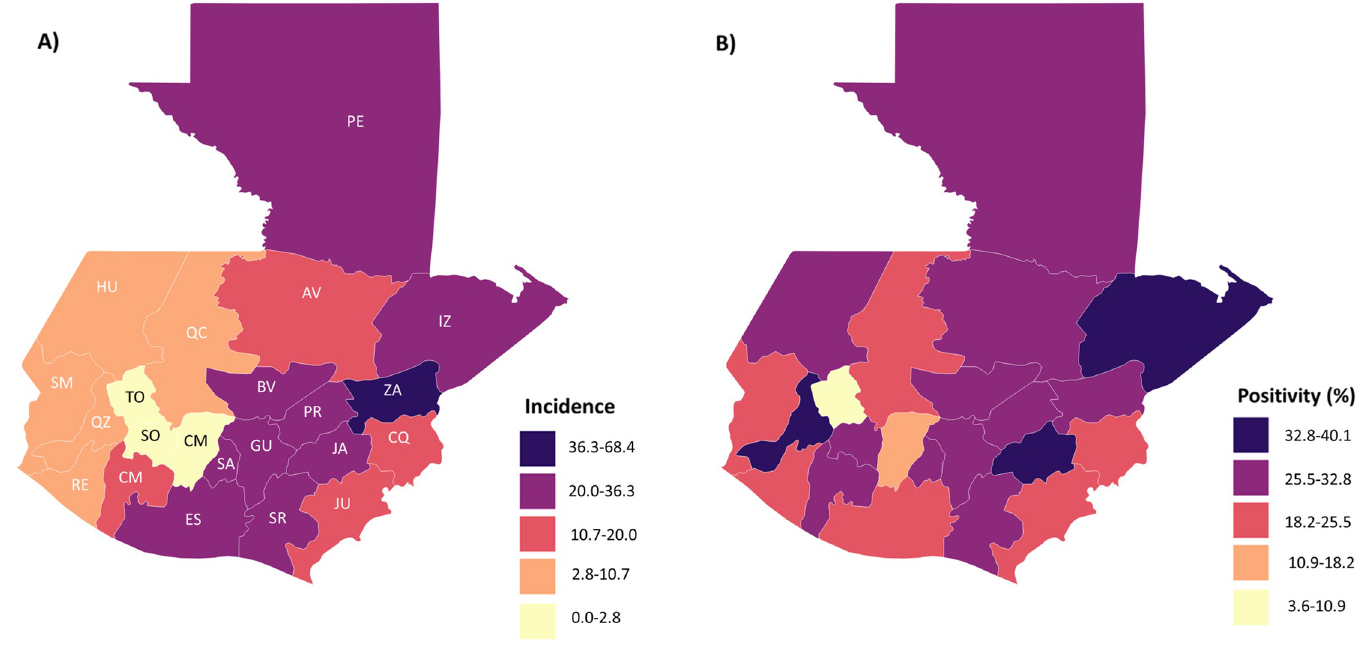
Fig 5. Geographic distribution of dengue in Guatemala (2000–2016). A. Number of dengue cases by Department (incidence per × 10,000 inhabitants). B. Proportion of samples tested that are positive for dengue. Darker colours denote higher values. (Population data from Wikipedia: Departments of Guatemala, 2011 population estimate).